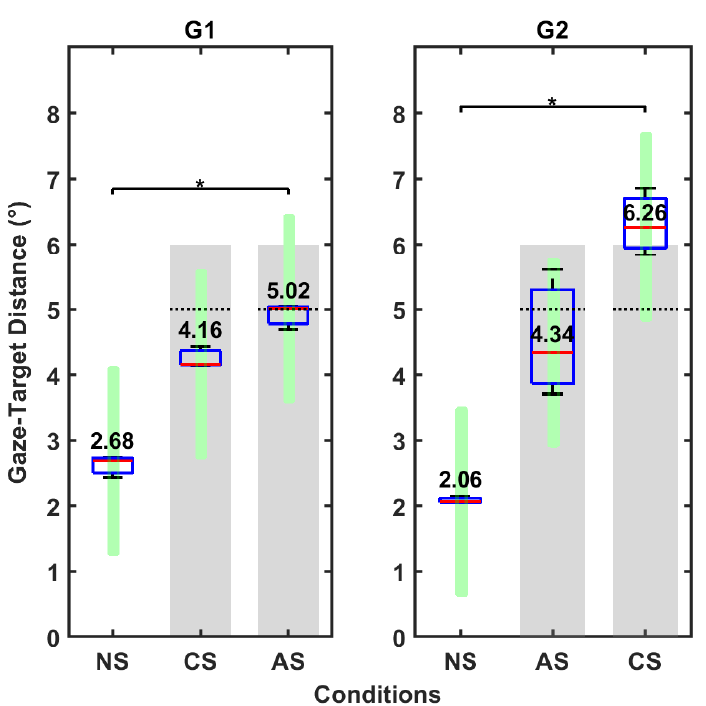
Figure 9. Box plots of the gaze-target distance for the two groups tested. A Kruskal–Wallis test indicated a significant difference between the three conditions for both groups. The post-hoc Dunn’s indicated differences in gaze behaviour when comparing the normal condition to the augmented scotoma (AS) for group 1 ( G1 ) and the scotoma condition (CS) for group 2 ( G2 ). Both p -values were below 0.05 (indicated by the asterisk). The target cover area (in green) is both above the intended scotoma cover area (in gray) and the scotoma area with cover errors (scotoma trailing area, above the dotted lines). The values above the median line (red) of the box plots are the median value of the pre-processed gaze-target distance for all subjects across all three